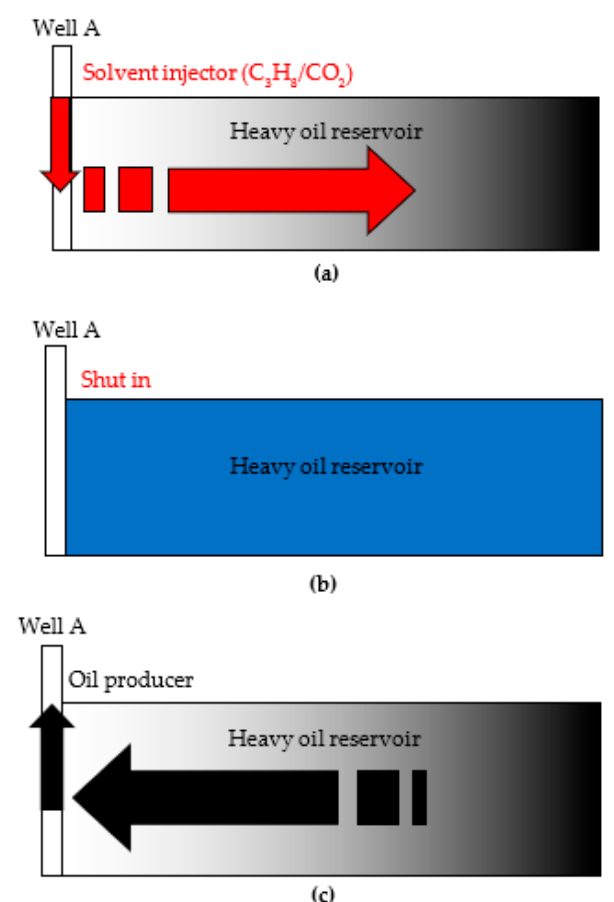
Figure 2. Flow charts of three periods in each cycle of the cyclic solvent injection (CSI) process in a one-well configuration: ( a ) solvent injection from Well A; ( b ) solvent soaking; and ( c ) fluids production from Well A.